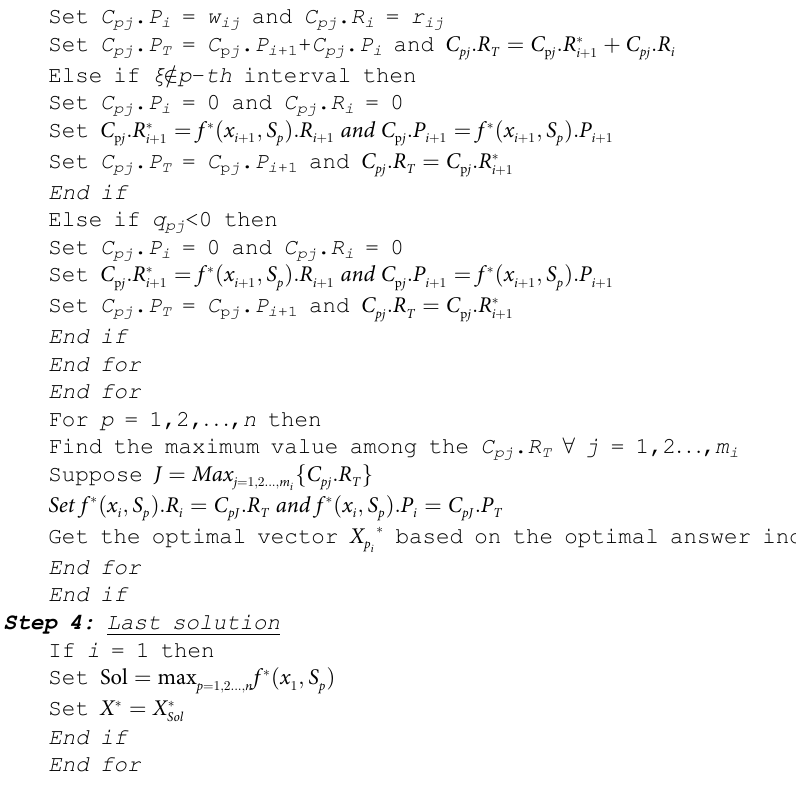
Figs 1 and 2 show the flowchart of the proposed algorithm based on dynamic programming to better understand the suggested